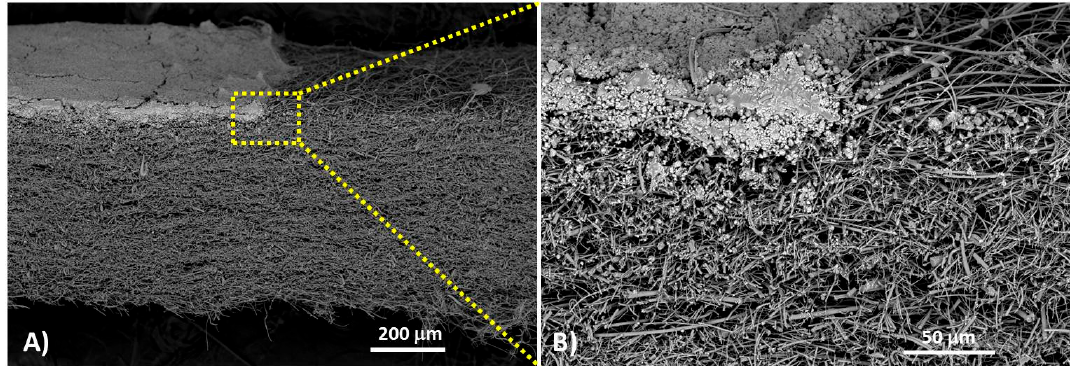
Figure 4. SEM micrographs (backscattered electron composition image—BEI, 10 kV, no gold sputtered, 90×) of a cross ‐ section of a PAS4mg along the edge of the Au@TiO 2 layer showing the layer arrangement on top of the quartz filter ( A ); a magnification of the particle distribution under the top layer (430×) ( B ).